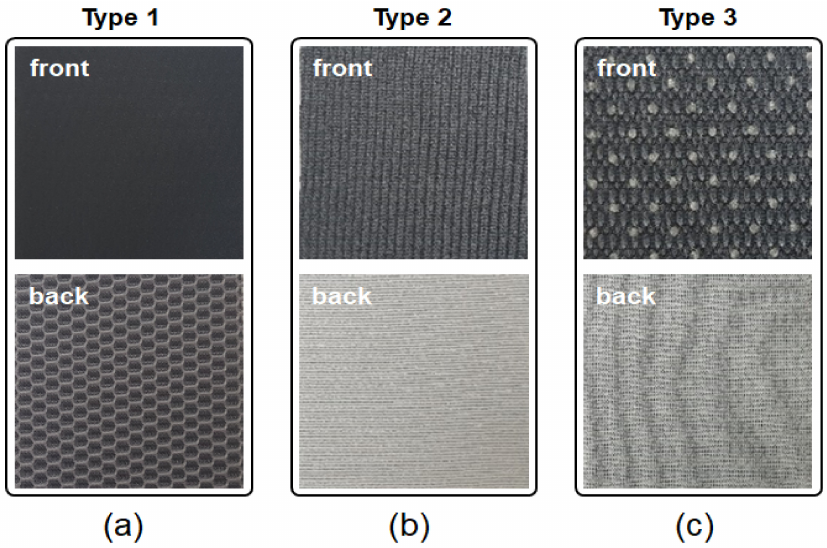
Figure 1. ( a ) The pictures of the front and back of Type 1 fabric; ( b ) The pictures of the front and back of Type 2 fabric; ( c ) The pictures of the front and back of Type 3